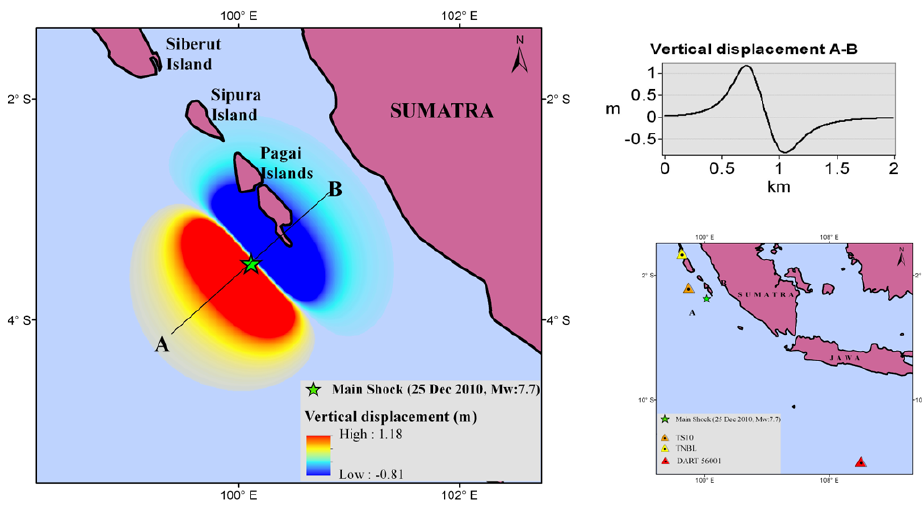
Fig. 13. Vertical dislocation of the sea floor, (b) Cross section of AB, (c) Location of the buoys.